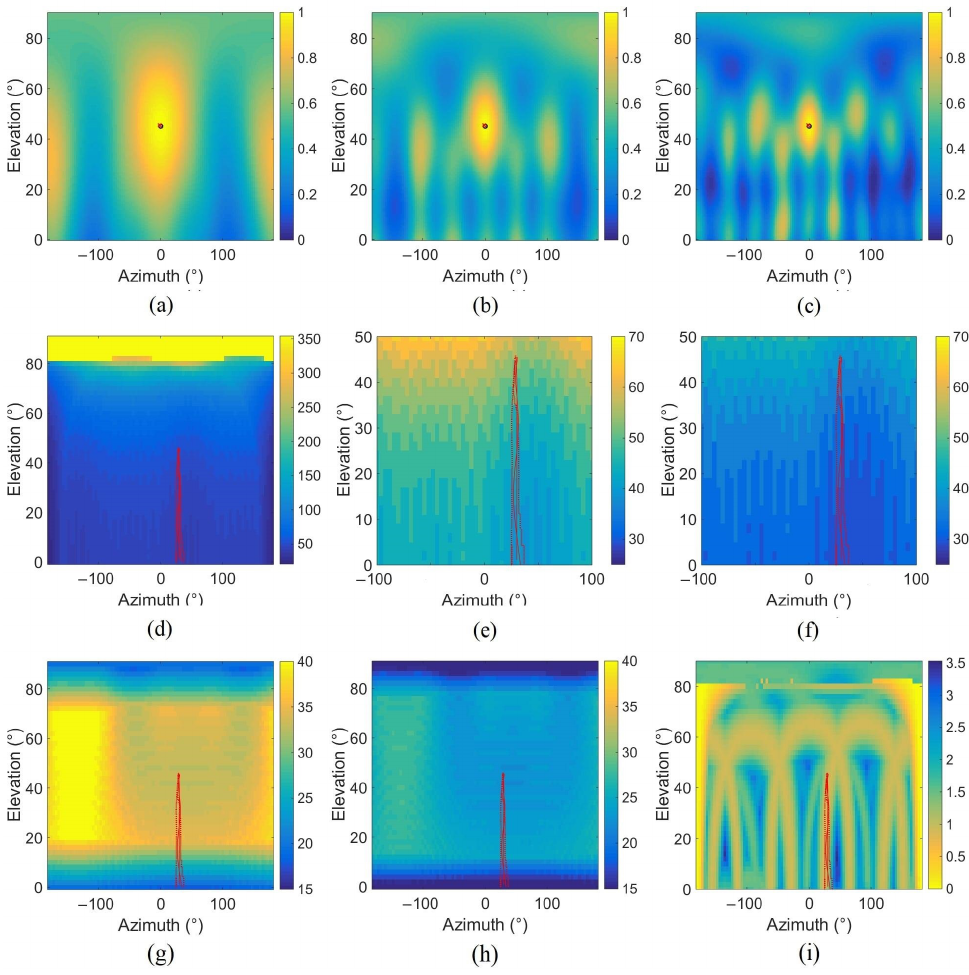
Figure 4. Directivity pattern of the array for (0°, 45°) direction and 175 Hz ( a ), 350 Hz ( b ), 525 Hz ( c ), with characteristics for all the directions in the azimuth/elevation plane: main lobe azimuth width (°) for 350 Hz ( d ), zoom for 350 Hz ( e ) and 525 Hz ( f ), main lobe elevation width (°) for 350 Hz ( g ) and 525 Hz ( h ), maximum side-lobe level (dB) for 350 Hz ( i ). The studied flight trajectories are in